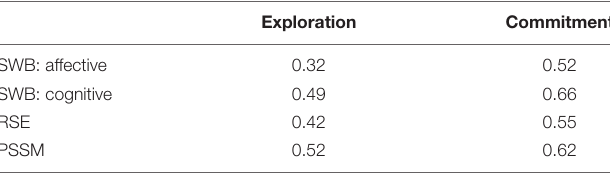
TABLE 8 | Correlations and regression coefficients between the Doctoral Student Identity Scale factors and the factors of SWB, RSE, and PSSM ( n =